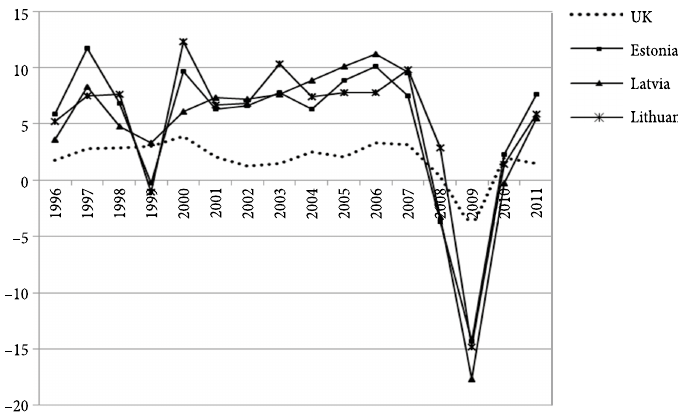
Fig. 2. Real GDP growth rates in the Baltic States and the EU Source : Eurostat (2012).